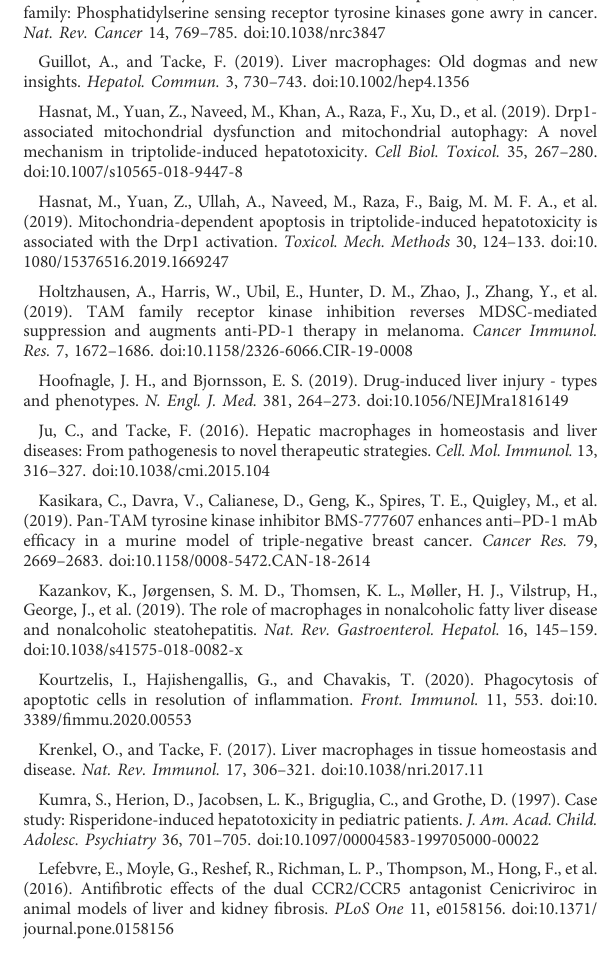
SUPPLEMENTARY FIGURE S1 Graph depicting percentage of liver with cleaved caspase-3 (A), MPO (B), CD11b (C), and F4/80 (D) positive cells in mice treated with TP (500 μ g/kg), LPS (0.1 mg/kg) or both. Results were expressed as means ± SEM. Statistical analysis was performed using One-way ANOVA followed by Tukey ’ s Multiple Comparison Test. p < 0.05 was considered to be statistically different. SUPPLEMENTARY FIGURE S2 Graph depicting percentage of liver with cleaved caspase-3 (A), MPO (B), CD11b (C), and F4/80 (D) positive cells in mice treated with TP (500 μ g/kg), LPS (0.1 mg/kg), Clodronate liposomes (200 μ L/mouse) or its negative control. Results were expressed as means ± SEM. Statistical analysis was performed using One-way ANOVA followed by Tukey ’ s Multiple Comparison Test. p < 0.05 was considered to be statistically